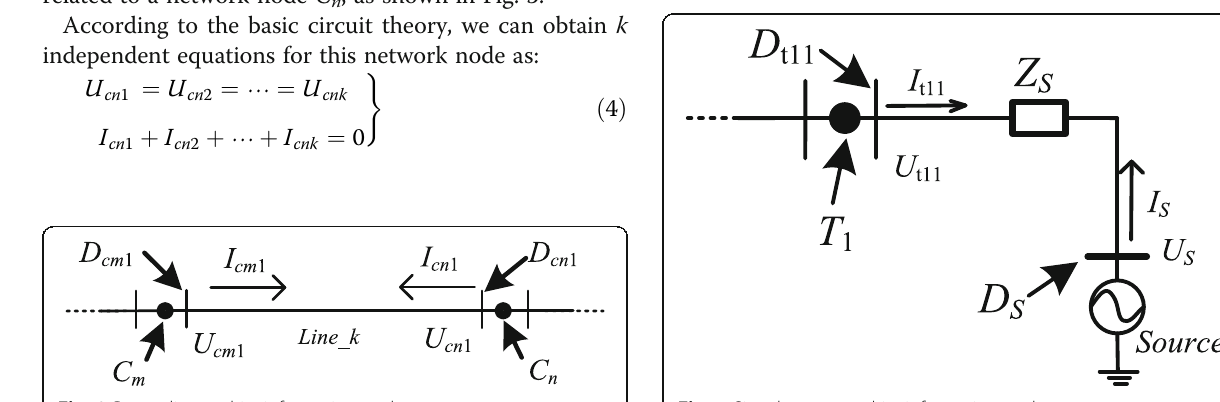
Fig. 2 Power line and its information nodes